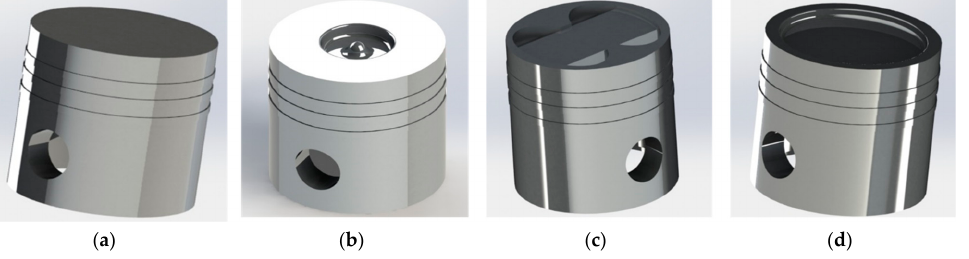
Figure 2. Multi piston design consideration: ( a ). Flat head-A; ( b )-bowl design-B; ( c )-bowl design-C and; (d) bowl design-D.